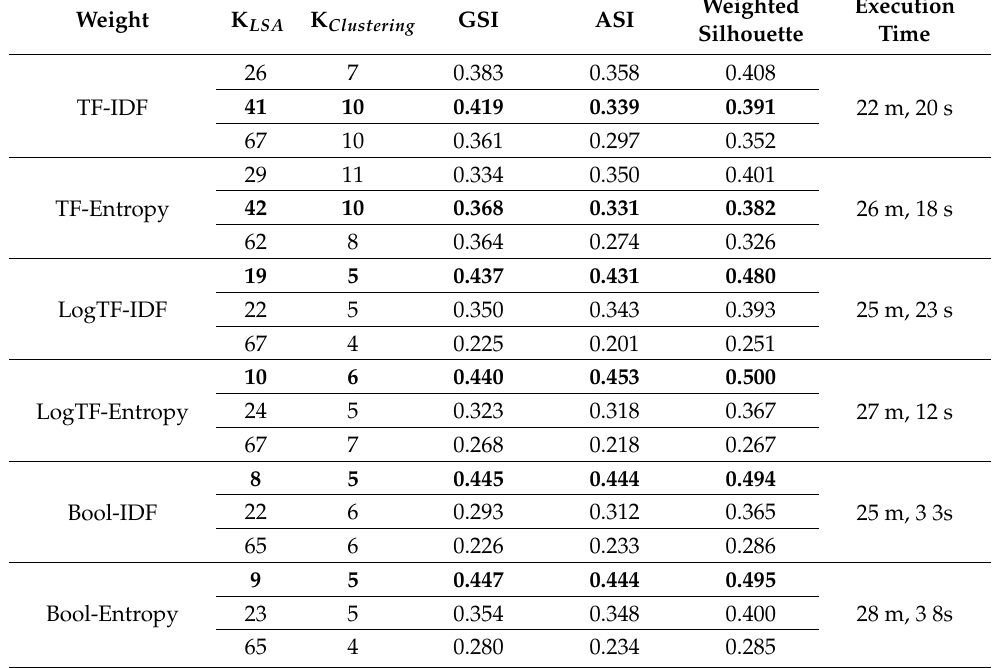
Table 4. Experimental results for D1 through the joint-approach. Weight K